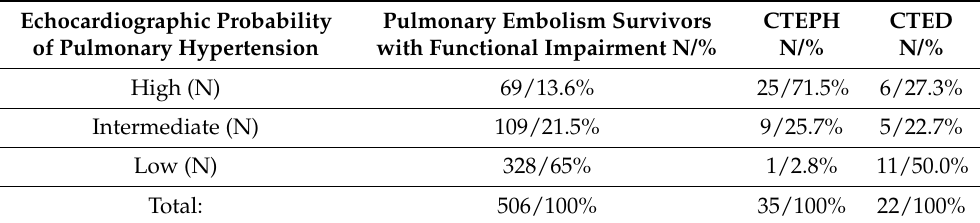
Table 3. Echocardiographic probability of pulmonary hypertension according ESC 2015 guidelines in 506 pulmonary embolism survivors with functional impairment.